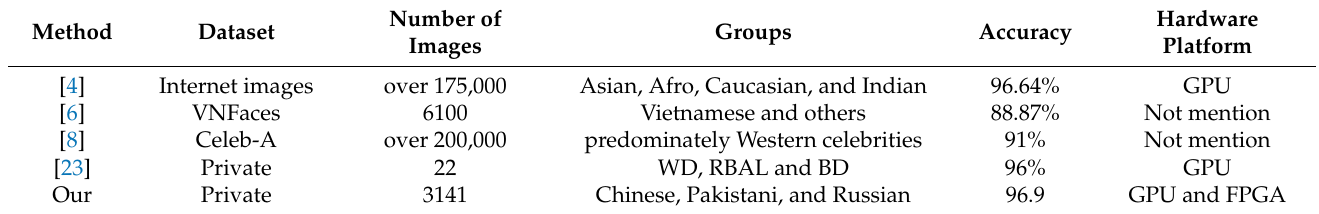
Table 1. Performance comparison